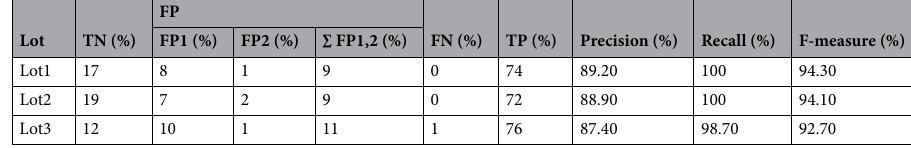
Table 9. Results of commercial Waterboxx in Lots. Average F-measure of commercial Waterboxx in Lots = 93.7%.